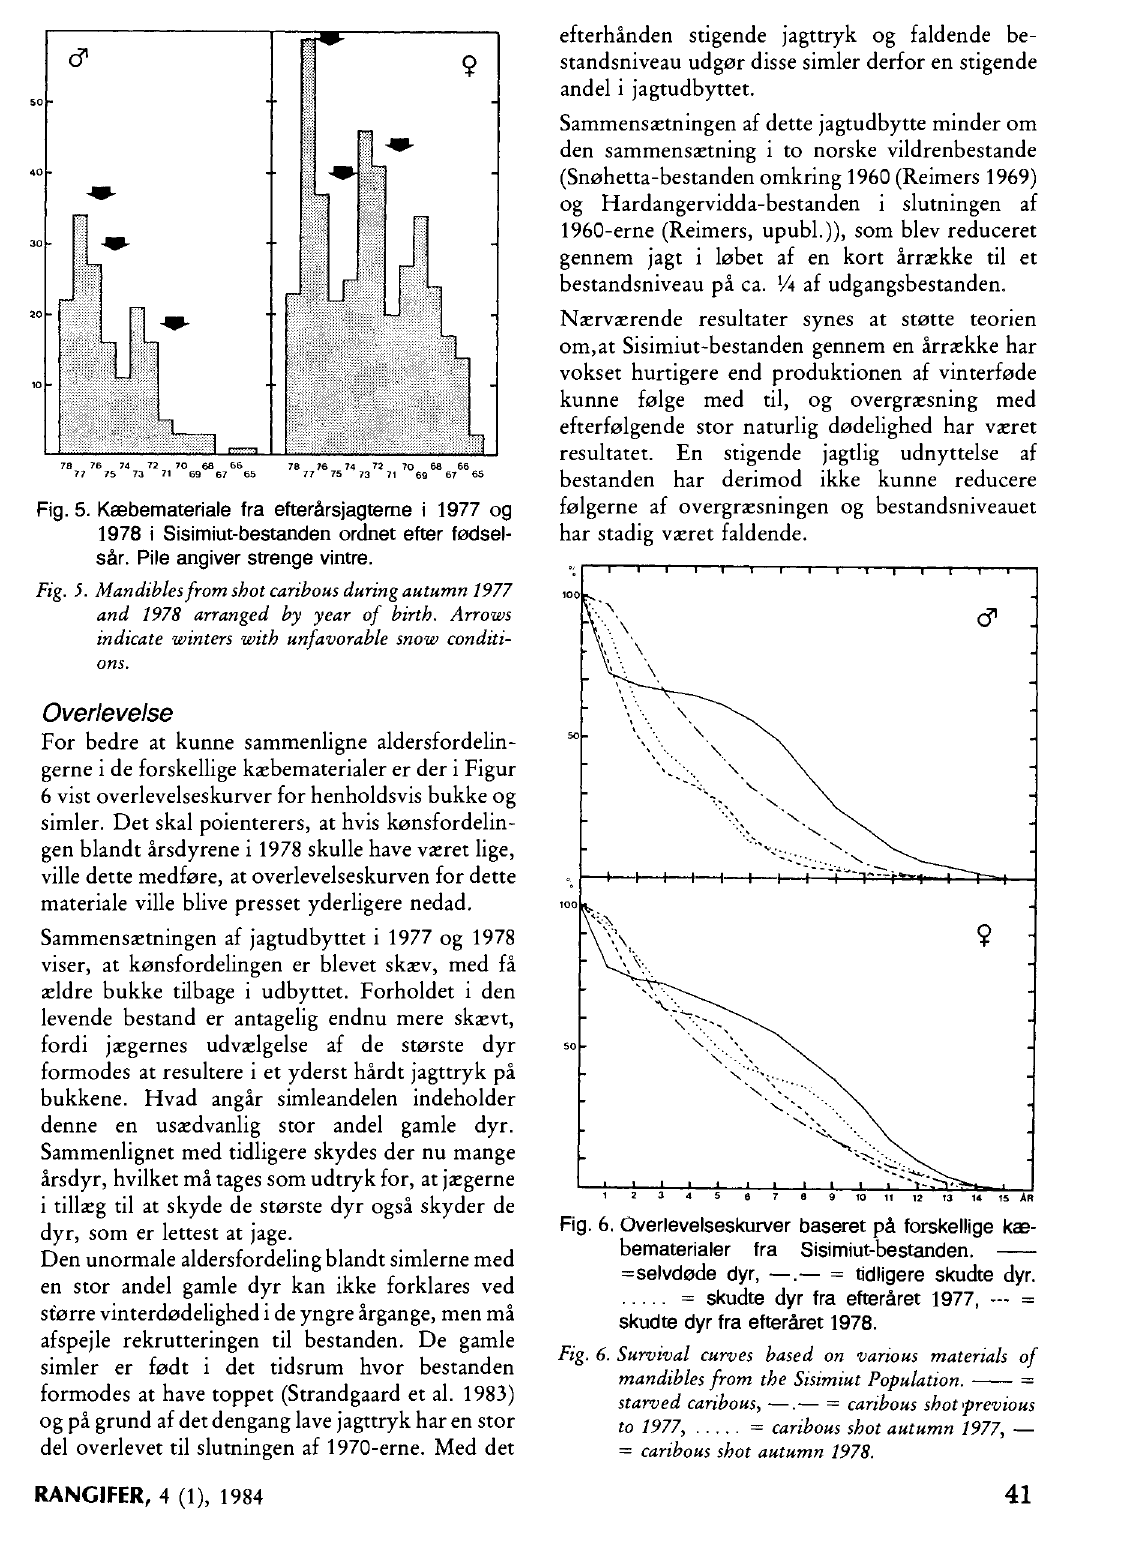
Fig. 6. Survival curves based on various materials of mandibles from the Sisimiut Population. = starved caribous, —.— = caribous shot previous to 1977, = caribous shot autumn 1977, — = caribous shot autumn